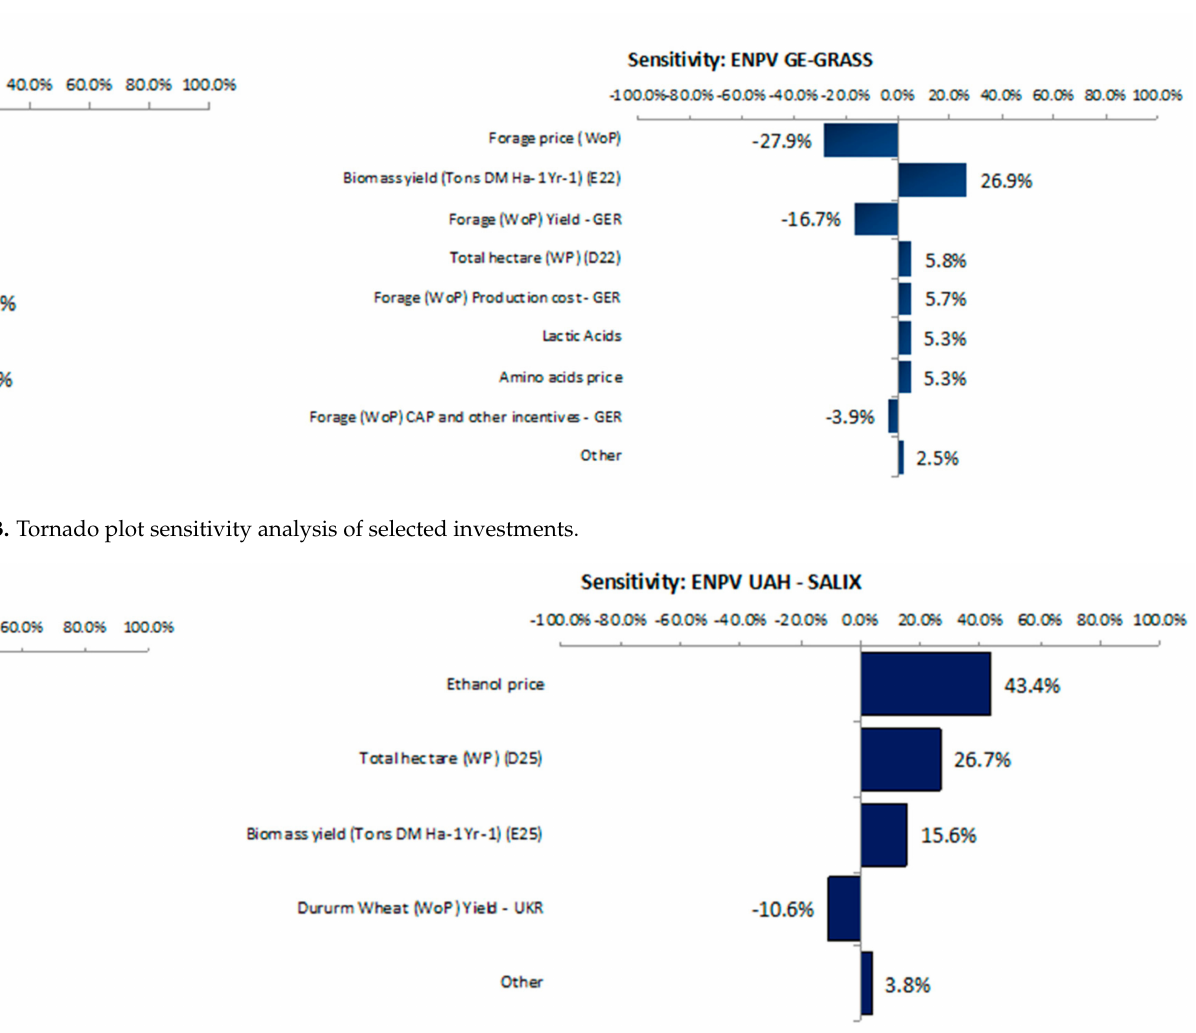
Figure A4. Tornado plot sensitivity analysis of selected